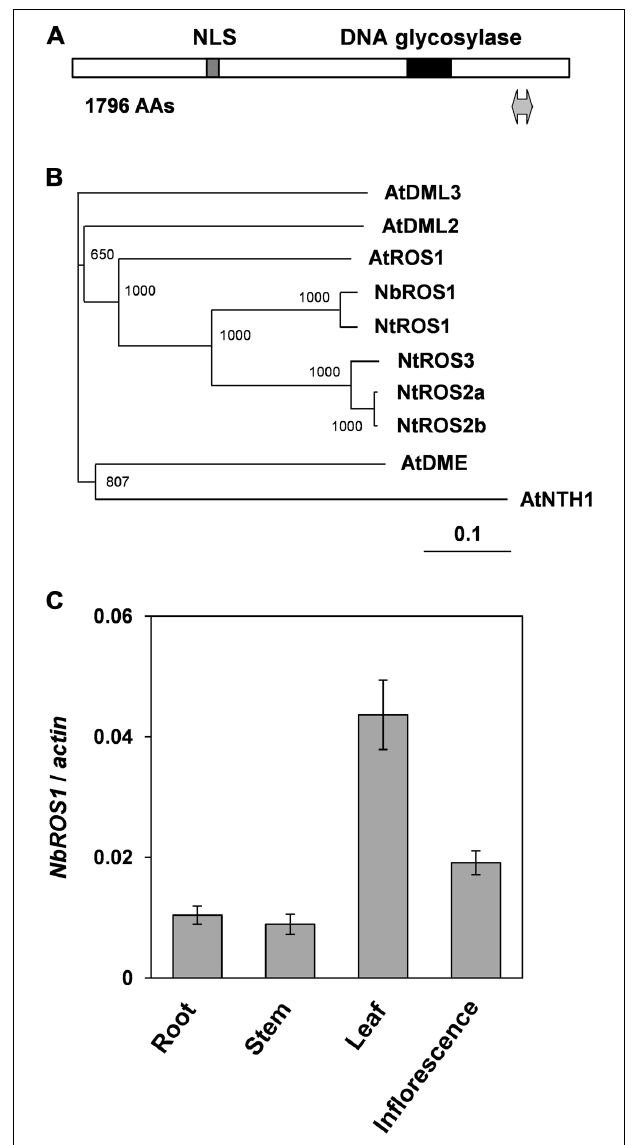
FIGURE 1 | Characterization of ROS1 ortholog in N. benthamiana . (A) Structure of NbROS1 protein. Protein size is shown in number of amino acids (AAs). Hatched and black boxes indicate the nuclear localization signal and DNA glycosylase domain, respectively.The region inserted into the CMV-A1 vector is indicated by a thick line with arrowheads at each end. (B) Phylogenetic relationships of DNA glycosylases.The phylogenetic tree was constructed using the neighbor-joining method based on protein sequences deduced from the nucleotide sequences of the genes. Bootstrap values of 1000 replicates are shown. A scale bar represents branch length. Protein sequence of AtNTH1 was used as the outgroup to root the tree.The following sequences were included in the analysis. AtNTH1, Arabidopsis thaliana NTH1 (CAC16135); AtDME, A. thaliana DEMETER (NP_001078527); AtDML2, A. thaliana DEMETER-Like2 (NP_187612); AtDML3, A. thaliana DEMETER-Like3 (NP_195132); AtROS1,